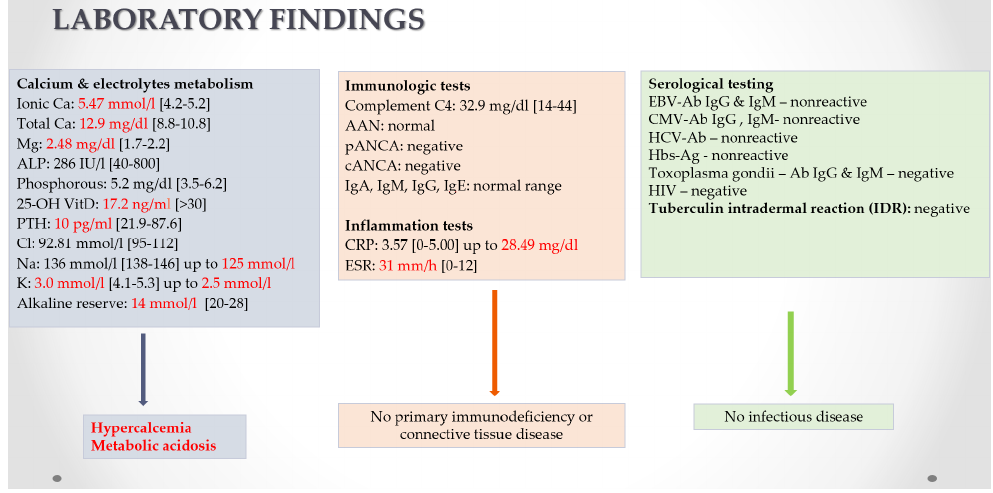
Figure 2. Differential diagnosis at presentation.